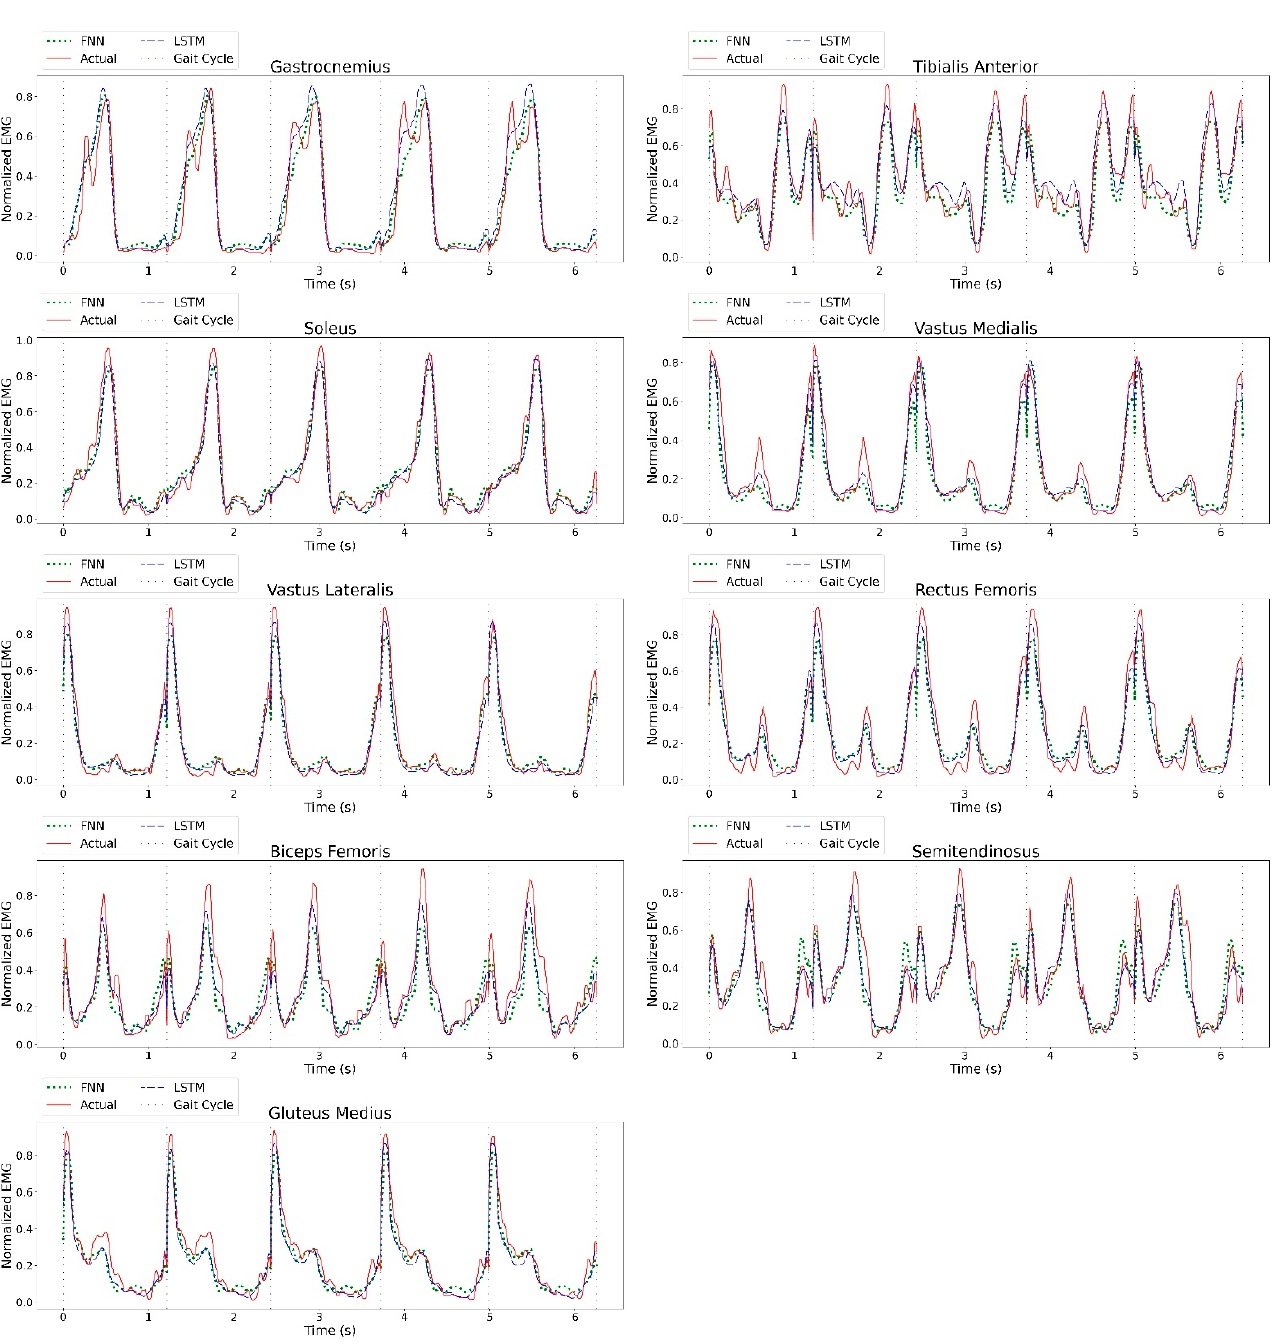
Figure A3. A plot of actual vs. predicted muscle activities of the test data (Sample C).